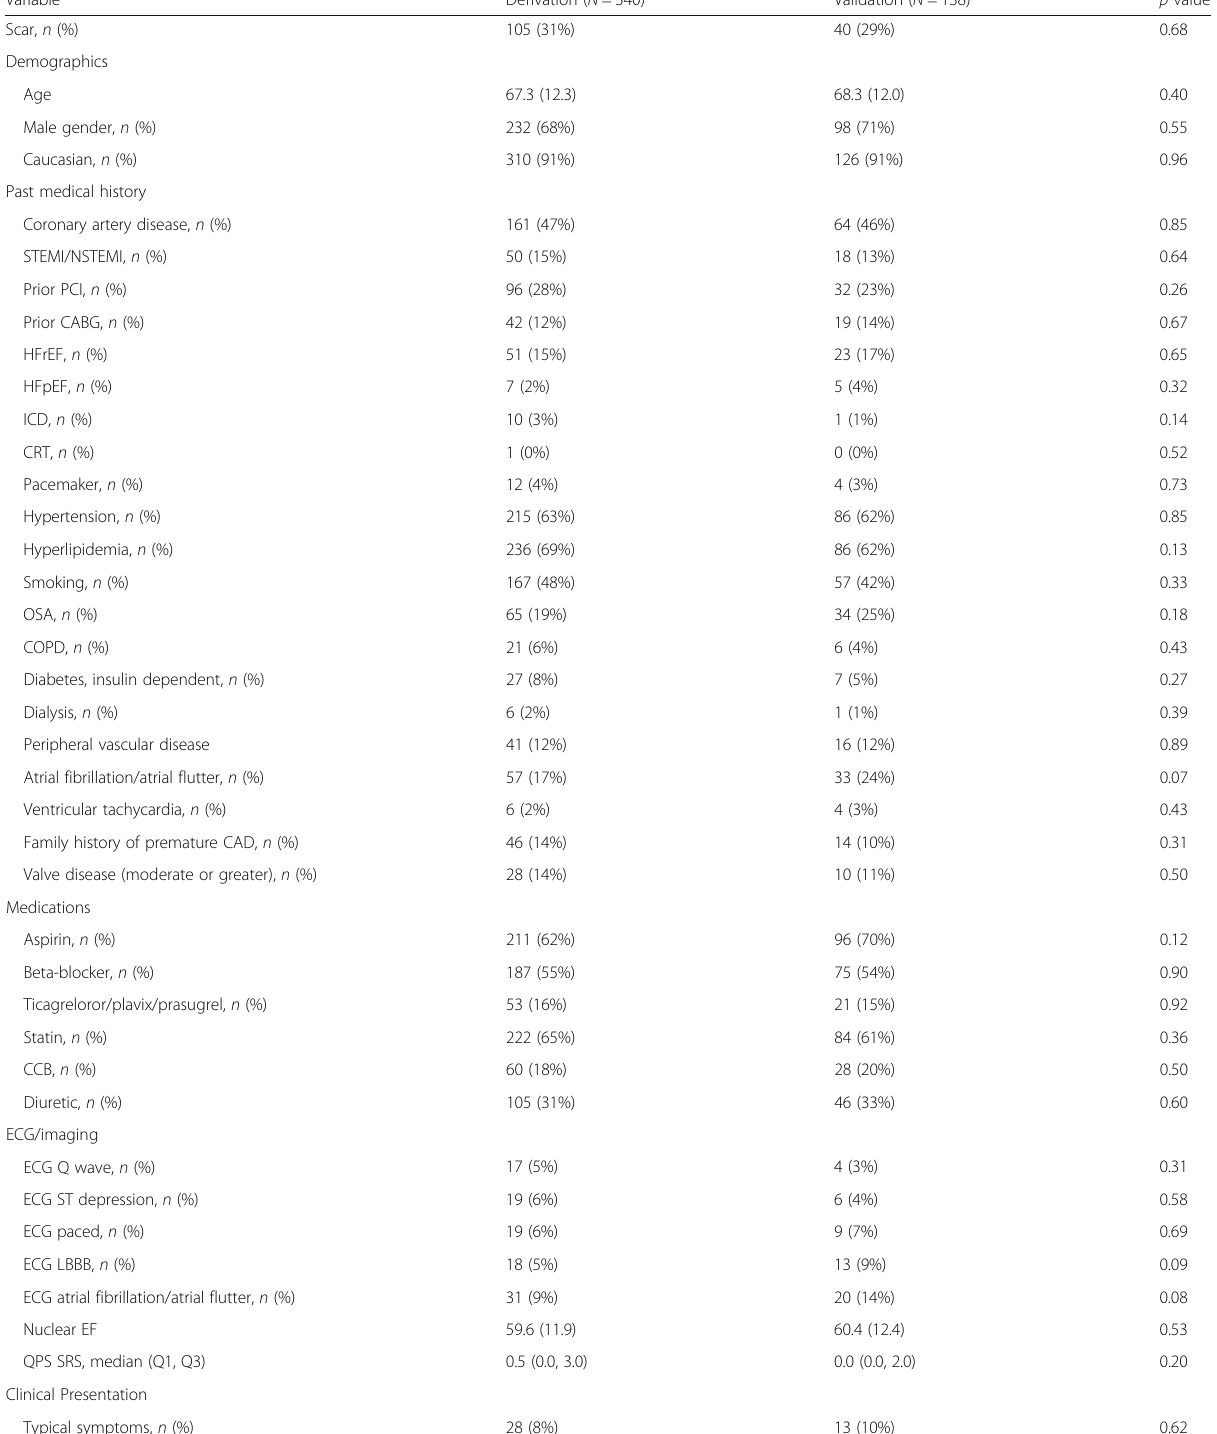
Table 1 Baseline clinical, laboratory, and imaging variables between the two